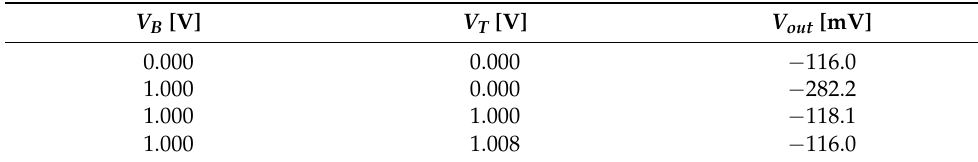
Table 4. Tested data of measuring gap mismatch.